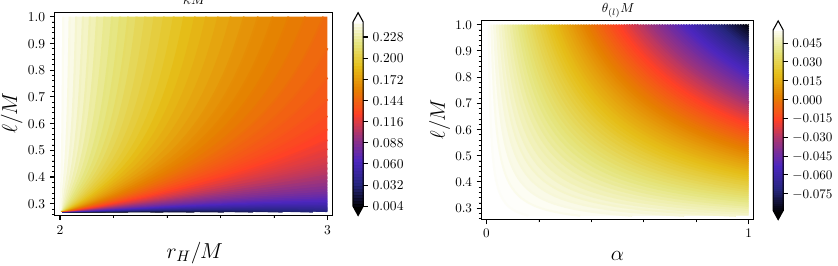
Figure 2. Left panel: gravitational constant κ (color scale) as function of the horizon radius r H and hairy parameter (cid:96) . The decoupling parameters α were eliminated using Equation (14). The Schwarzschild case corresponds to the extreme left vertical line. Right panel: expansion of the cross-section (color scale) along the null vector l for r = 2.3. Notice that, close to the upper right corner, r H > 2.3 (see Figure 1), resulting in a negative